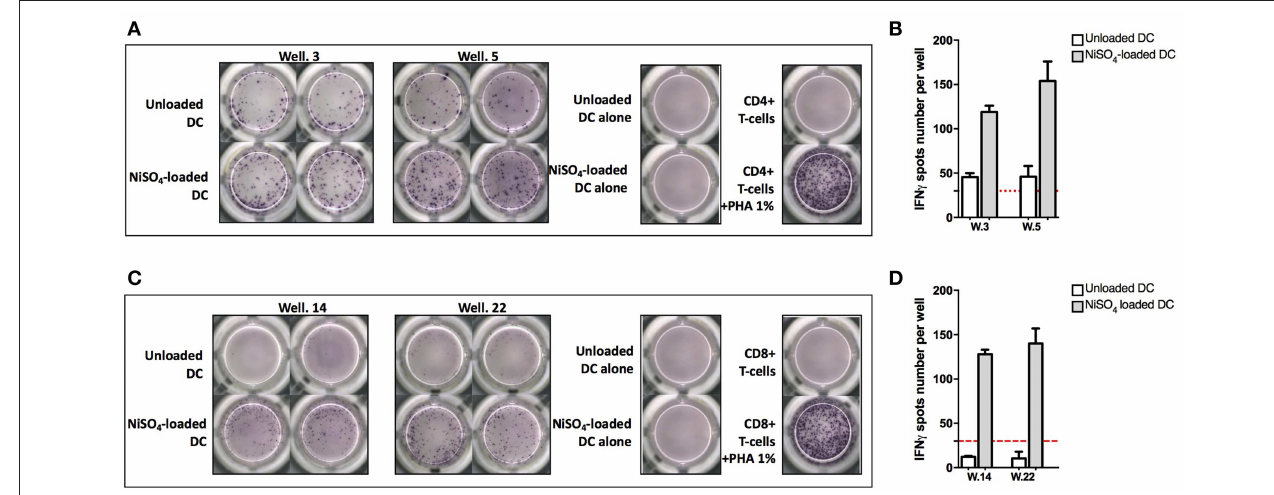
FIGURE 1 | Naïve CD4 + and CD8 + T-cell lines can recognize nickel. (A) IFN- γ ELISpot response of naïve CD4 + T cells from donor PR4 stimulated with unloaded DC or DC loaded with NiSO 4. (B) Spots count for naïve CD4 + T cells specific to nickel from donor PR4. Dashed line represents the minimum required spots count (count = 30) for the analysis to be considered acceptable. (C) IFN- γ ELISpot response of naïve CD8 + T cells from donor PR13 stimulated with unloaded DC or DC loaded with NiSO 4 . (D) Spots count for naïve CD8 + T cells specific to nickel from donor PR13. Dashed line represents the minimum required spots count (count = 30) for the analysis to be considered acceptable. PHA: Phytohemagglutinin.